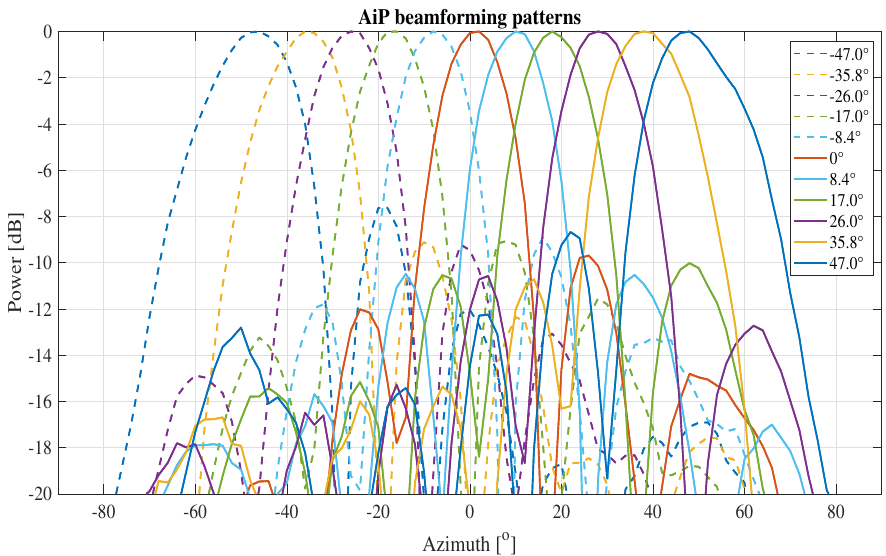
Figure 8. AiP beamforming patterns at different